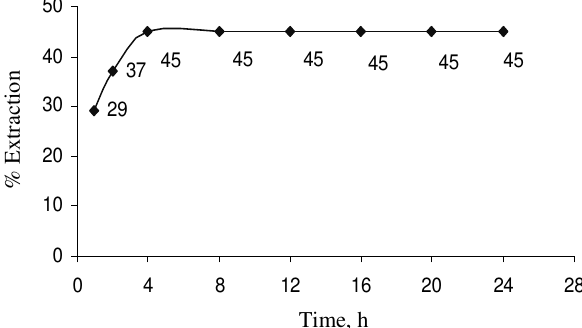
Figure 2. Effect of time on the competitive extraction of Cu(II).